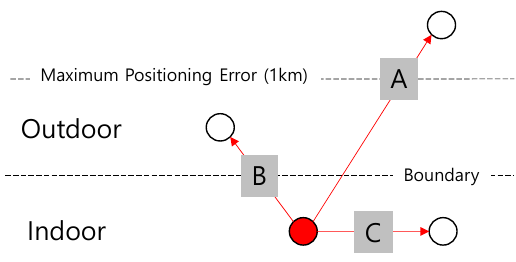
Figure 9. Three cases of user’s movement in our domain.